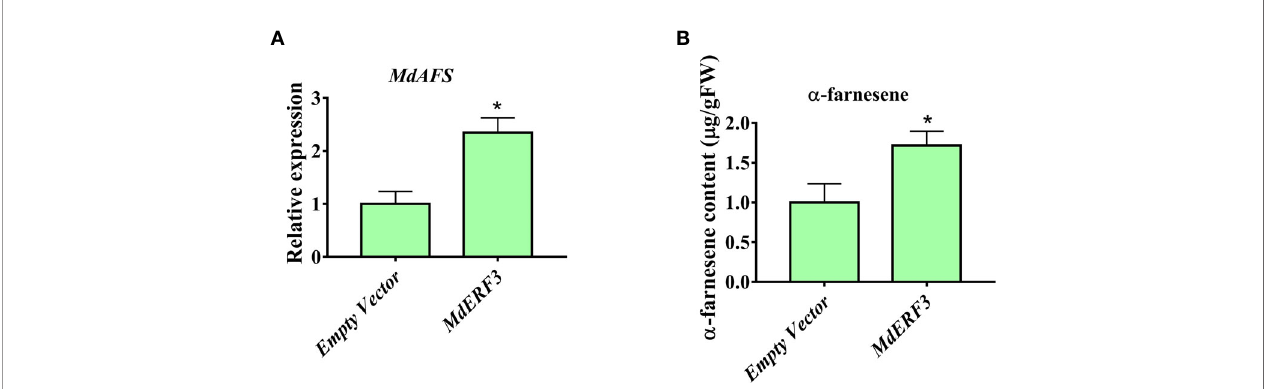
FIGURE 6 | Transient expression of MdERF3 in apple peel. (A) Relative MdAFS gene expression in apple peel injected with Empty Vector and MdERF3. (B) a -farnesene content in peel in fi ltrated with MdERF3. More than three apples were injected for determination, and the data were the average value obtained. * indicates P < 0.05 compared to Empty Vector.